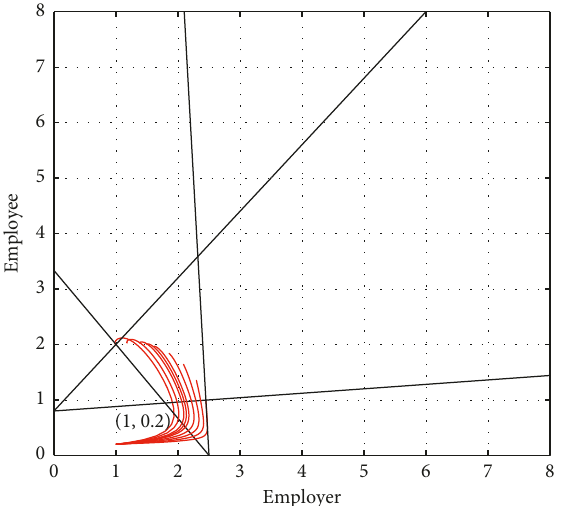
Figure 7: Simulation result with various c ( b